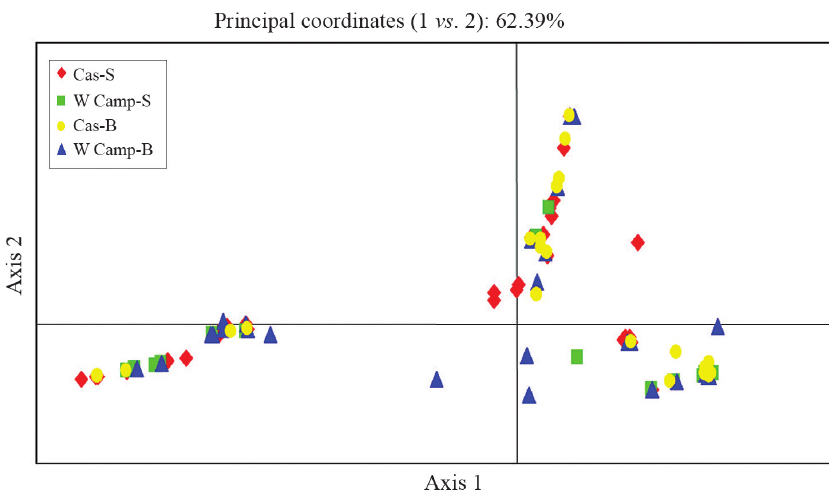
Figure 2 - Principal Coordinate Analysis (PCoA) plot: the first PC accounts for 37.82% of variance, while the second PC accounts for 25.07% (Cas: Cabras; W Camp: western Campidano; B: MBU method; S: STD